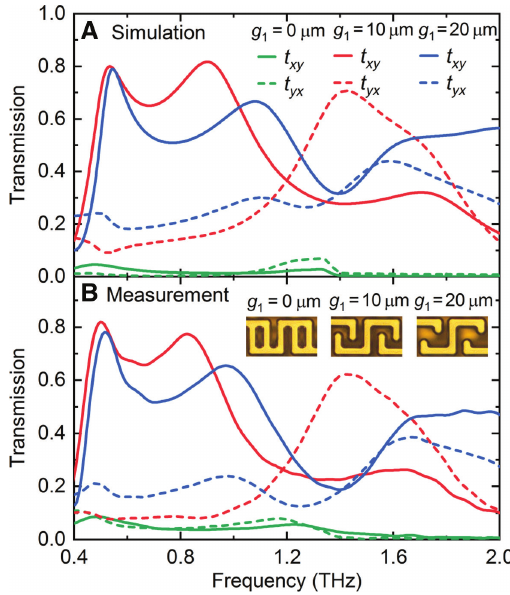
Figure 6: Cross-polarization transmission with different vertical distance g . 1 (A) simulation and (B)